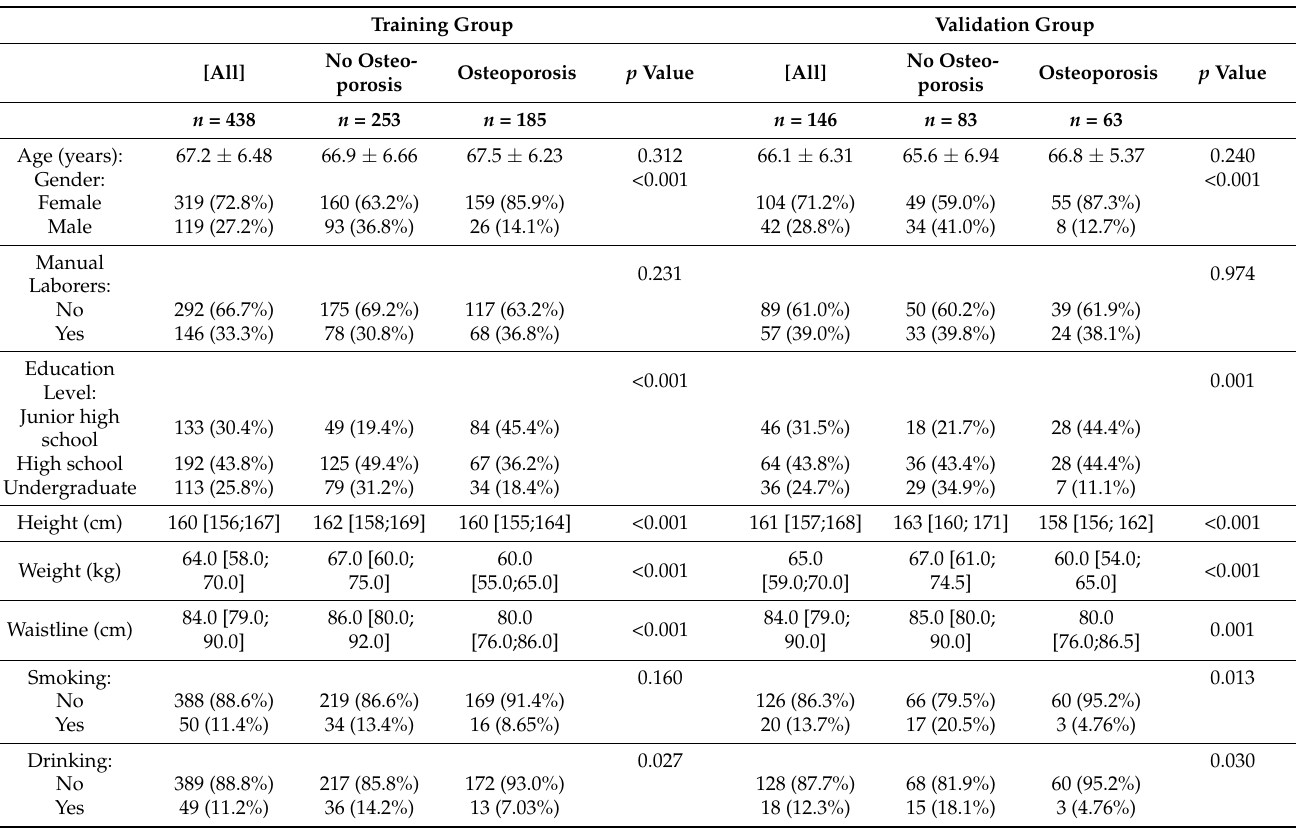
Table 1. Baseline data and between-group (No osteoporosis and Osteoporosis) comparisons were made for the training and validation